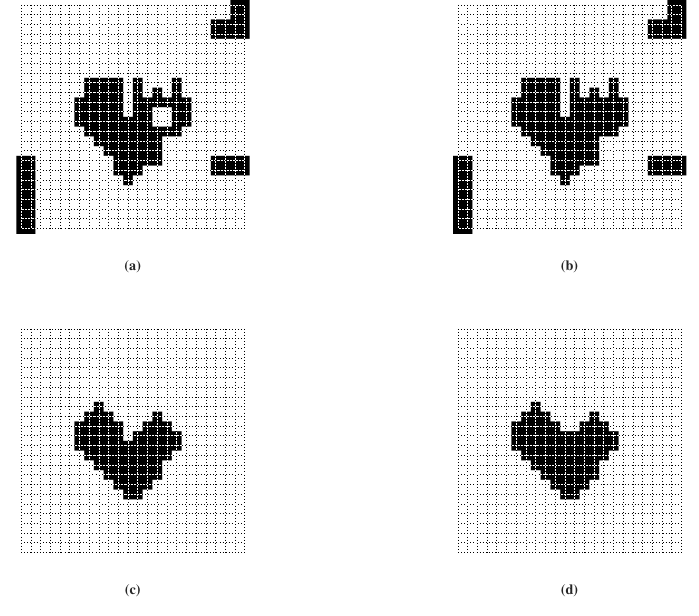
Figure 6. The refinement procedure. ( a ) the mask image with the tongue mask approximately located at the center. As can be observed, there are noises surrounding the tongue and the tongue is coarse with a small ’hole’ inside; ( b ) the mask image after using the morphological reconstruction method (Algorithm 1); ( c ) the mask image after using the open operation; ( d ) the mask image after using the close